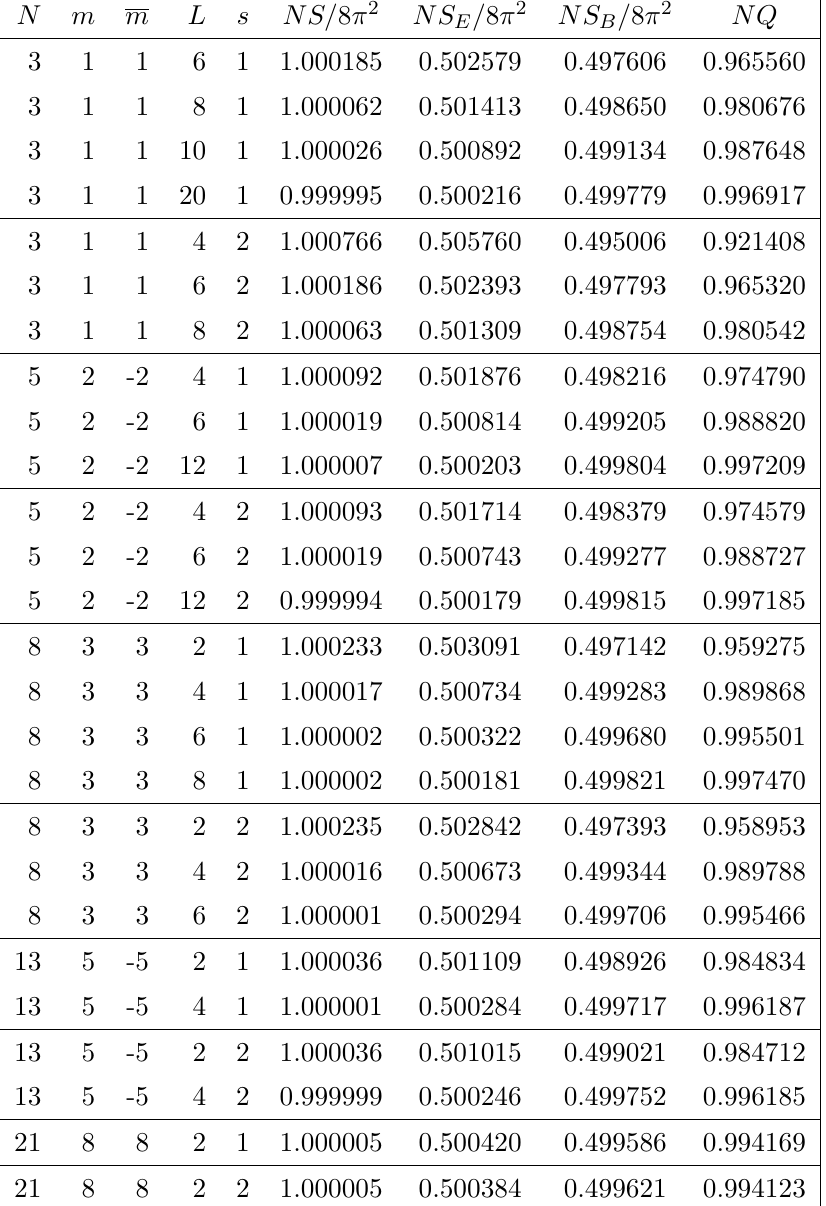
Table 1. Value of total action ( S ) and its electric ( S E ) and magnetic ( S B ) parts in units of 8 π 2 /N . We also give the value of N times the topological charge ( NQ ). Results are given for all our lattice configurations representing a continuum torus with periods: l and l = NLa , with a the lattice spacing. Quantities are reported with an error of 1 in the last 3 significant digit, taking into account the changes in the last iteration of the flow